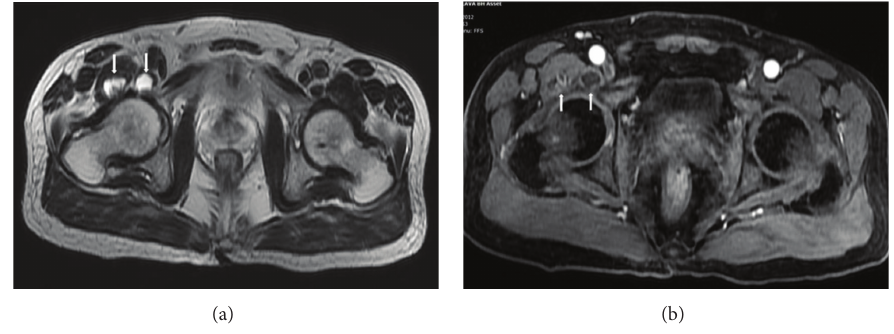
Figure 1: (a) Axial T2 weighted image demonstrates the periarticular collections extending into the right iliacus muscle and insertion of the psoas muscle (arrows). (b) Axial fat-saturated postcontrast T1 weighted image shows peripheral enhancement of the cystic collections mimicking abscess